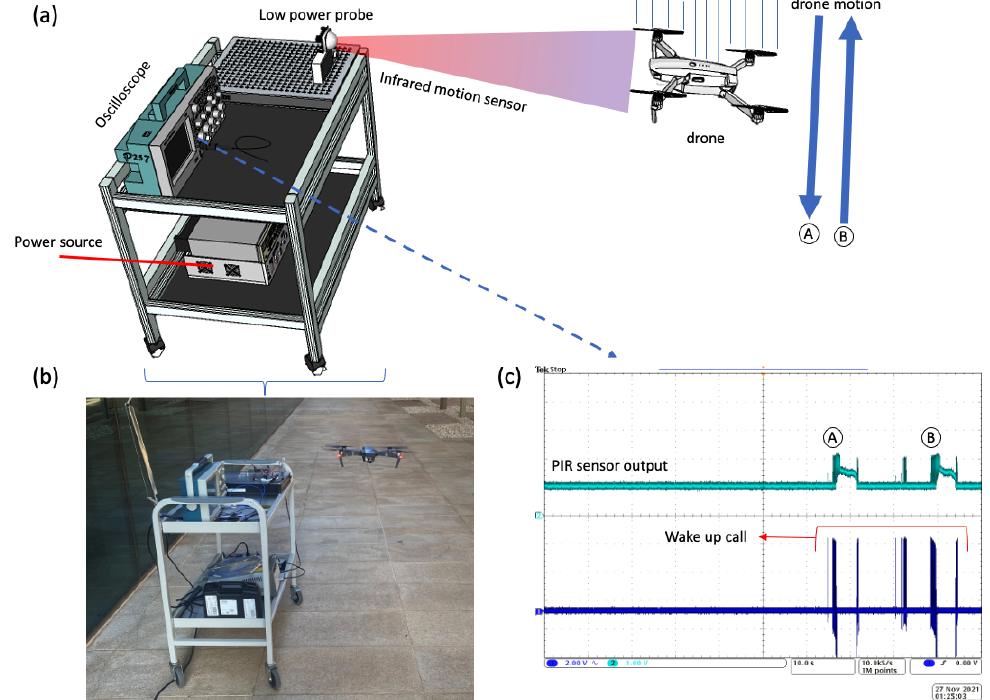
Figure 8. ( a ) Diagram of the wake-up using a UAV, ( b ) the device being woken up by a drone, ( c ) oscilloscope outputs of the infrared sensor (in light blue) and the interruption (in dark